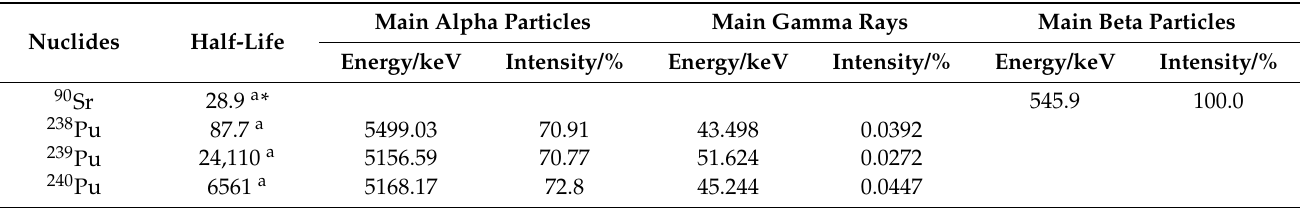
Table 6. Half-life, decay mode, and strongest decay energy of 90 Sr, 238 Pu, 239 Pu, and 240 Pu